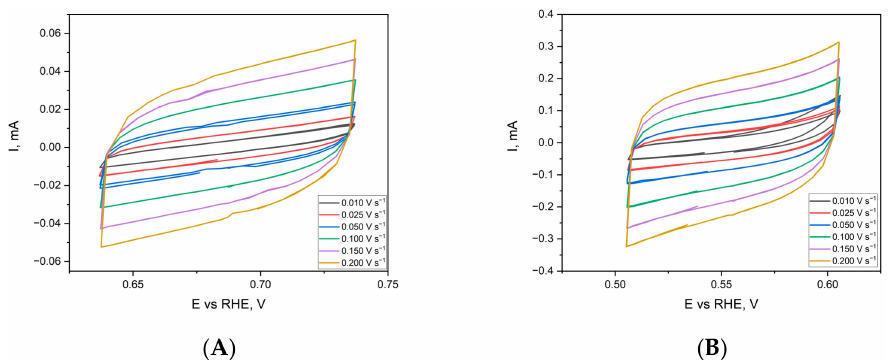
Figure 10. Cyclic voltammetry scans for flat Ni ( A ) and porous Ni sample ( B ) in 1 M NaOH electrolyte in the non-Faradaic potential region. CVs registered for different sweep rates between 0.01 and 0.2 V s − 1